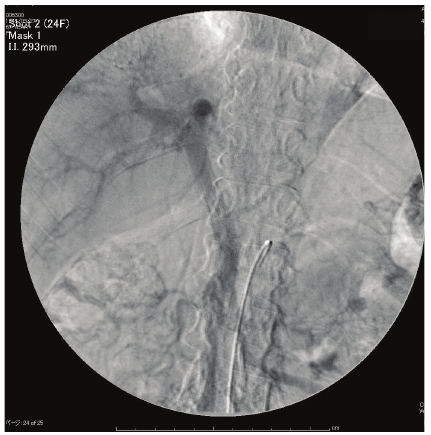
Figure 3: Superior mesenteric arterial portogram after TJO shows hepatopetal portal blood